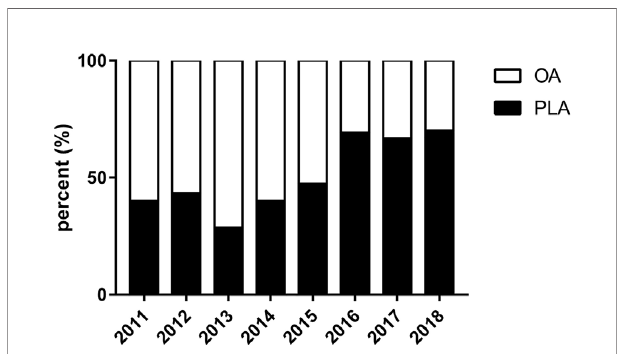
FIGURE 2 | Percent of PLA cases over time for GBC. GBC, gallbladder cancer; OA, open approach; PLA, primary